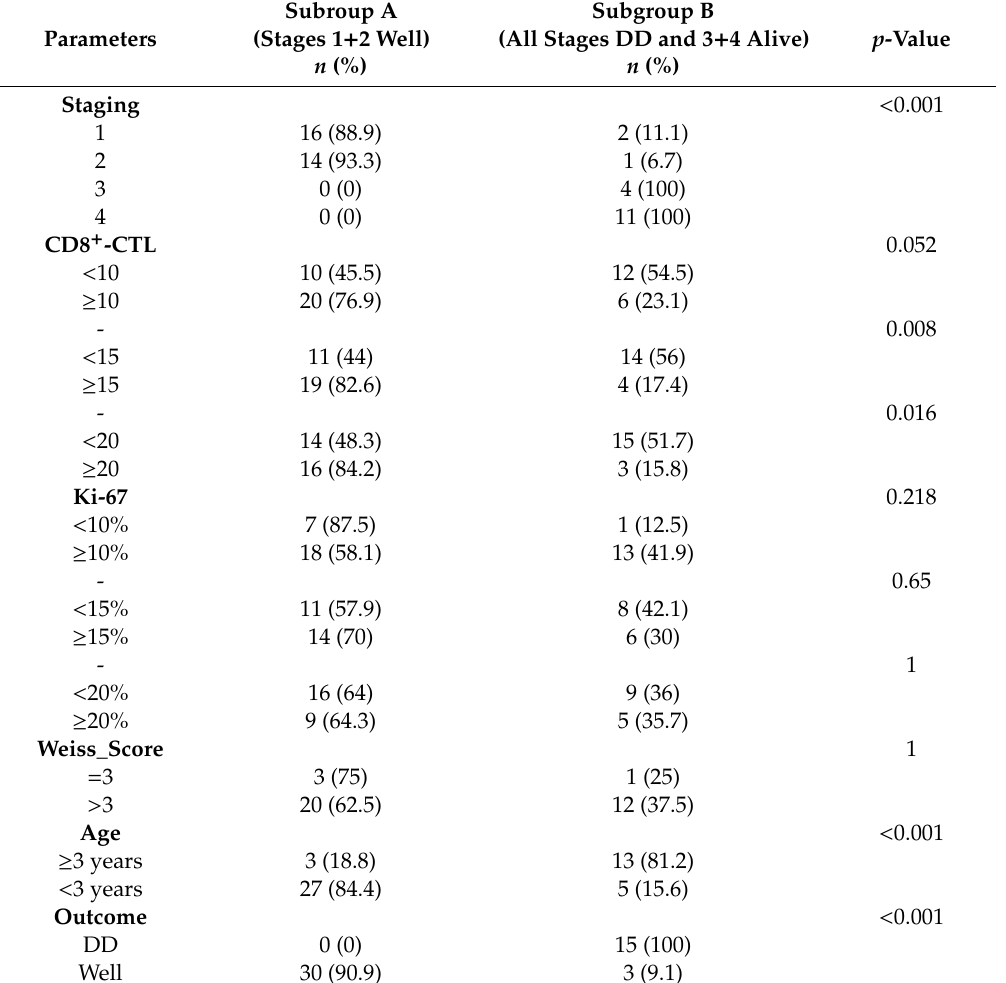
Table 3. Good (A) and worse (B) prognostic subgroups discriminated using di ff erent indices and